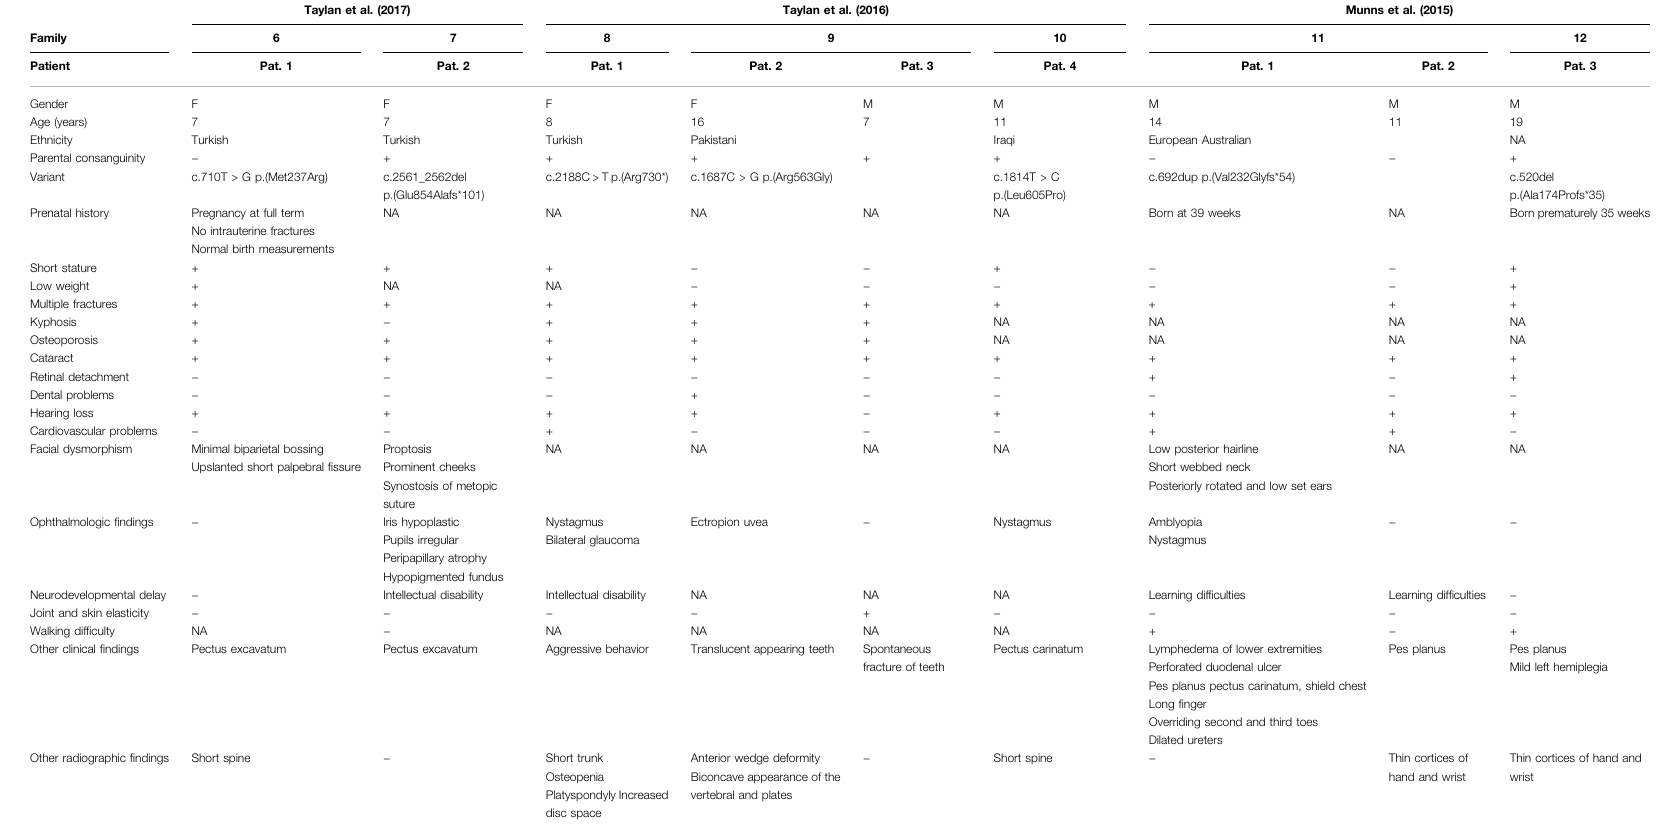
Other radiographic fi ndings Short spine